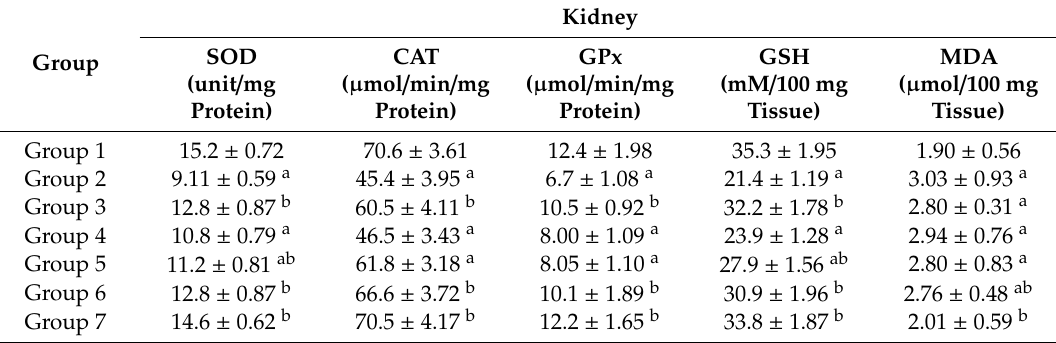
Table 6. E ff ect of methanolic extract of Punica granatum leaves (100, 200, 400, and 600 mg / kg; Groups 4–7) on renal oxidant–antioxidant parameters in nicotinamide / streptozotocin-induced type 2 diabetes in